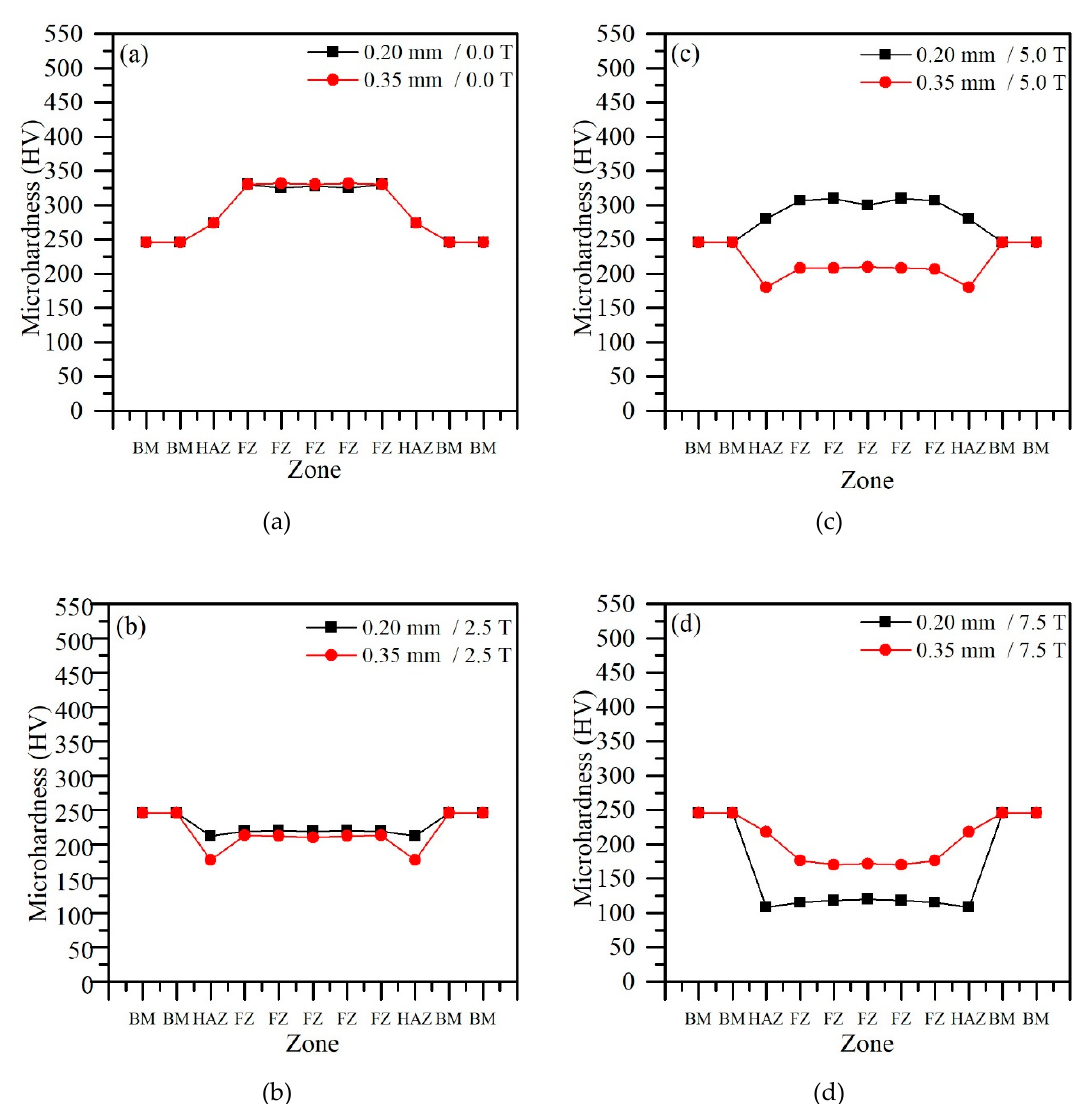
Figure 8. ( a ) Vickers microhardness for B = 0.0 T, ( c ) Vickers microhardness for B = 2.5 T, ( b ) Vickers microhardness for B = 5.0 T, and ( d ) Vickers microhardness for B = 7.5 T.